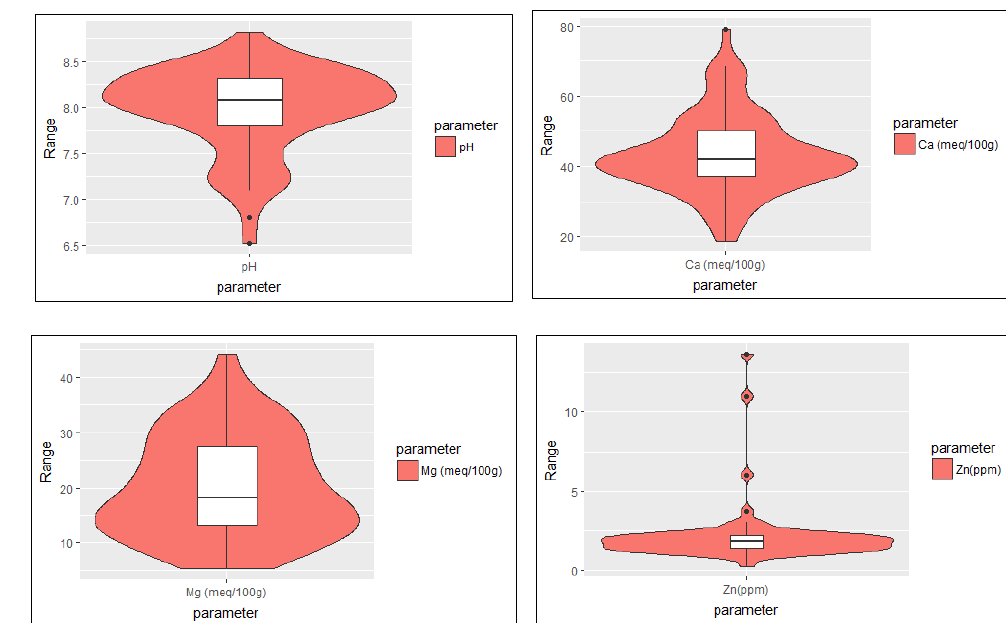
Figure 2. Violin plots for soil pH, Ca, Mg and